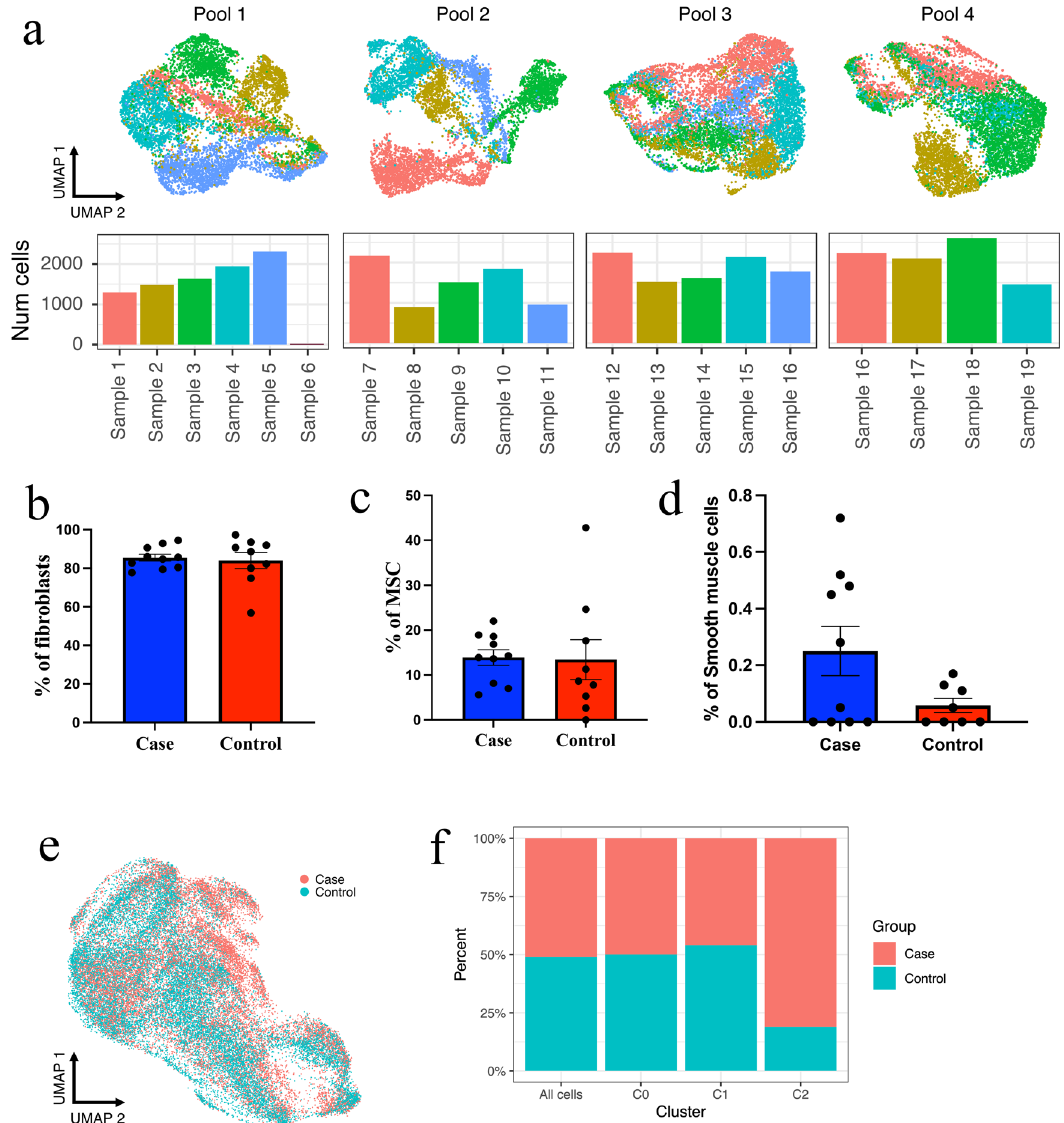
Fig. 4 Cell type and cell cluster relationship to endometriosis status. a Genotype data and demuxlet were used to deconvolute individual samples from the mixed pool of cells; 100% of cells were correctly assigned to the patient donor. In total 20 samples from 19 patients were loaded into 4 well of the 10X chromium controller. Overlaying clinical data and comparing the number of cells derived from women with endometriosis (cases, n = 10) and without endometriosis (controls, n = 9) using an unpaired t test found no signi fi cant difference between b the number of fi broblasts ( p = 0.7403), c the number of MSCs ( p = 0.9185) or d the number of smooth muscle cells ( p = 0.0723). e UMAP plot of scRNA-seq data labelled by endometriosis status. f Percentage of cells assigned case or control status across all cells and per cluster (cluster 0, 1 and 2). A Chi-squared comparison between each cluster con fi rmed